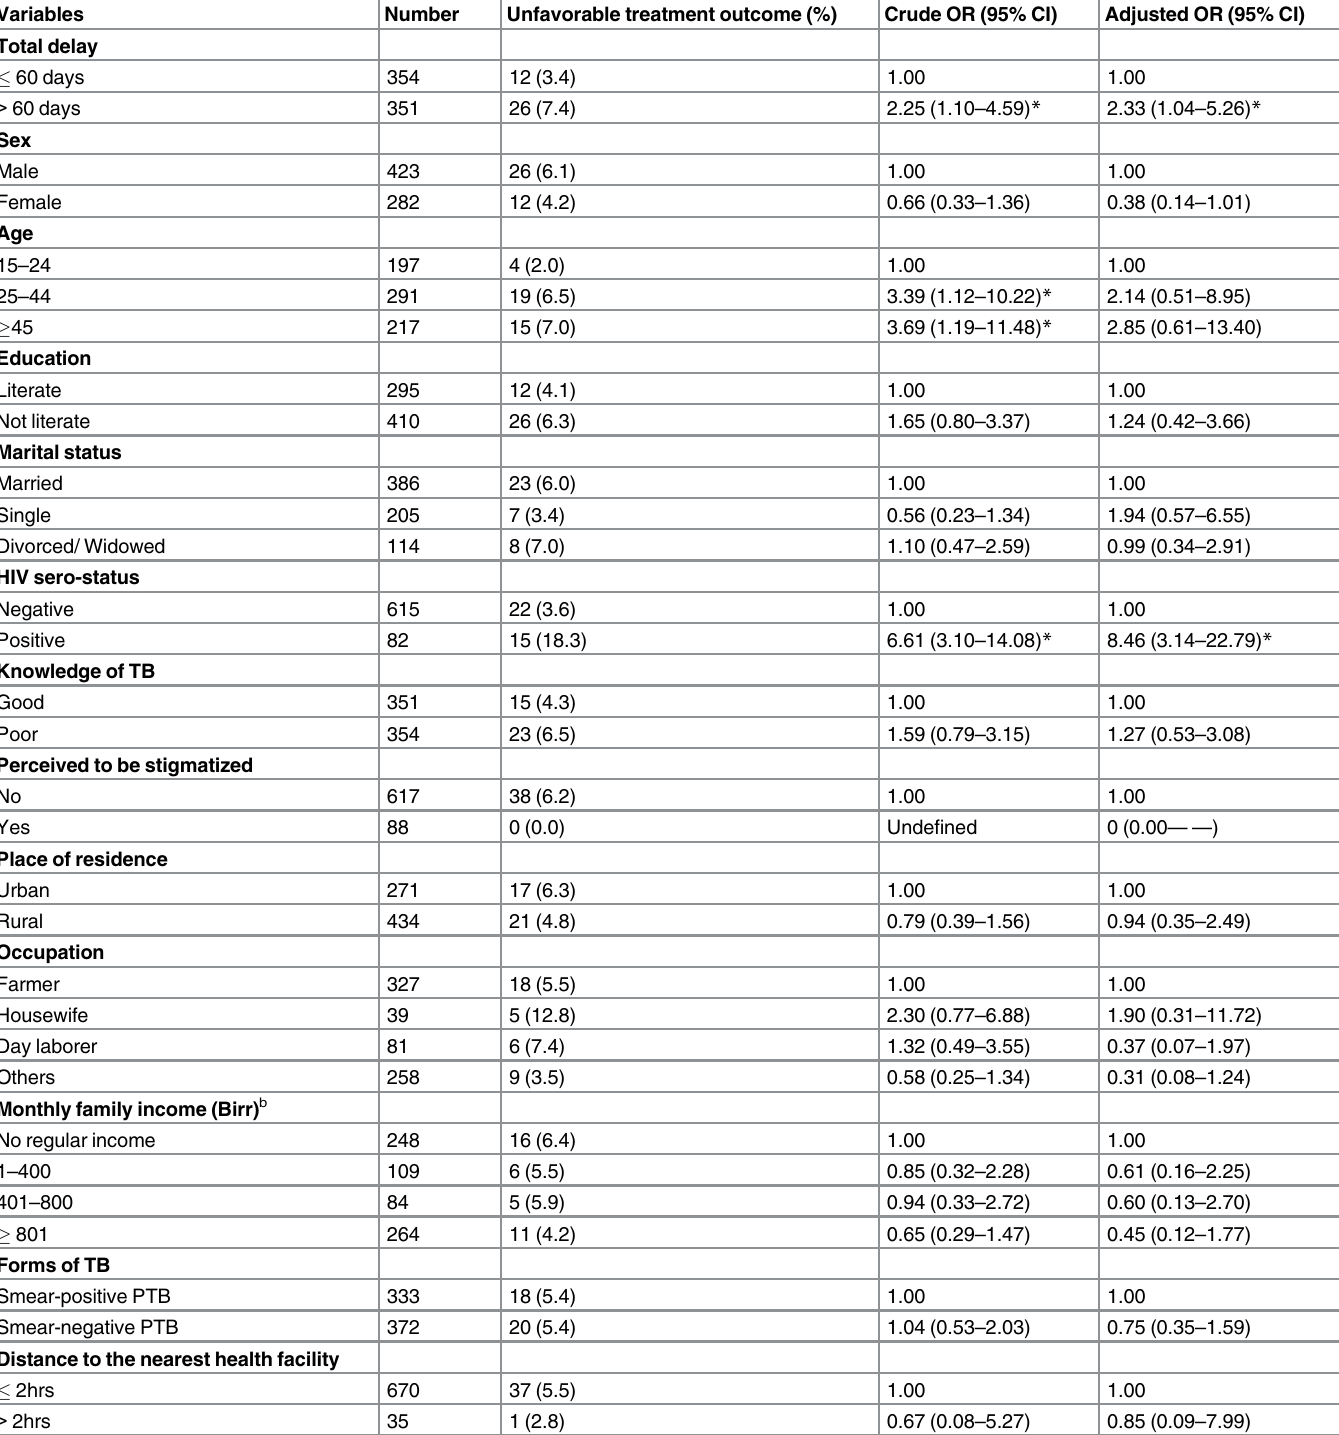
Table 6. Associations of socio-demographic and clinical factors with unfavorable treatment outcome of new PTB patients, October 2013 to May 2015, West Gojjam Zone,